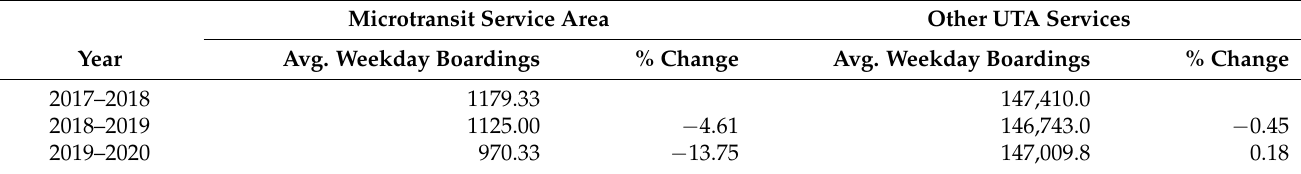
Table 5. Average Weekday Ridership, November through